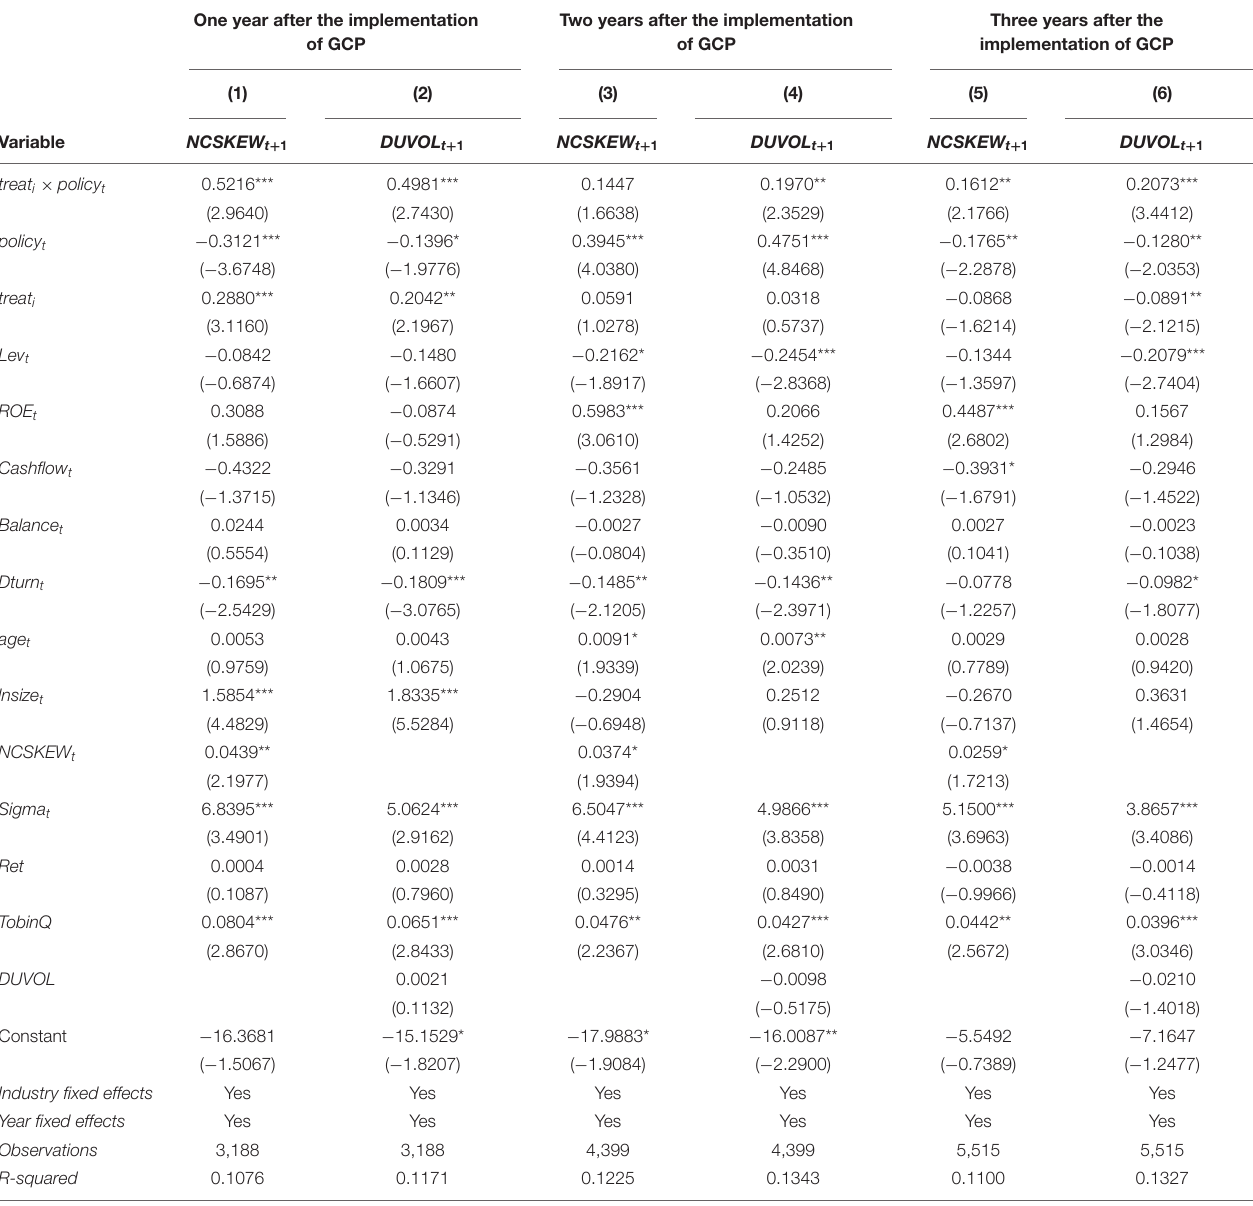
TABLE 6 | Short-term and long-term